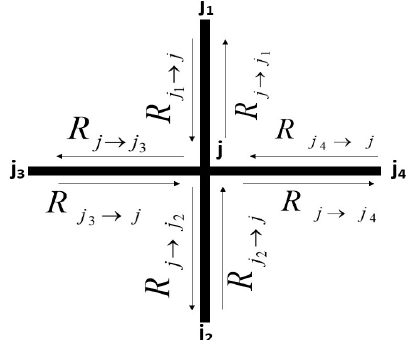
Figure 2. Representation of a 4-way intersection j.